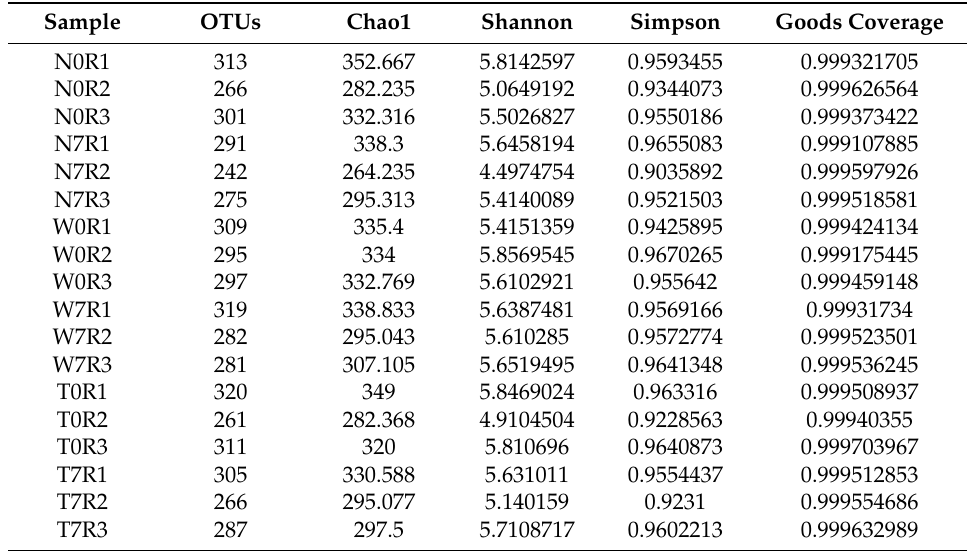
Table 2. Richness estimate and diversity index for gut samples under different diets: community diversity index and richness estimate for 18